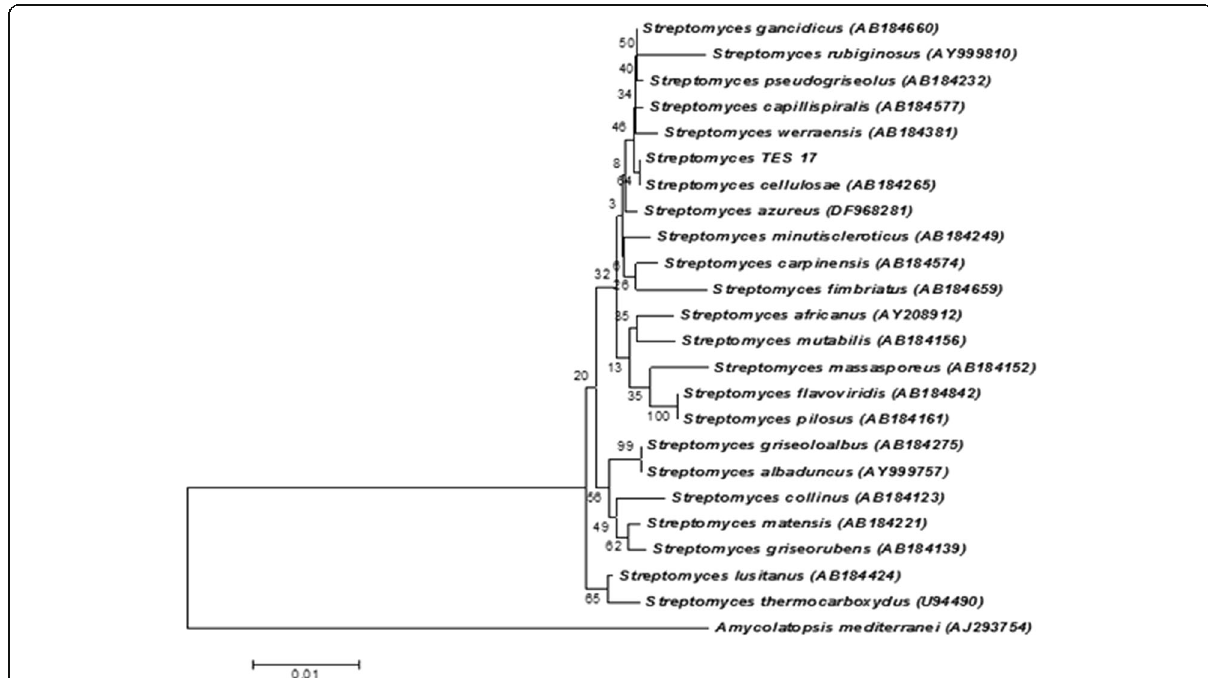
Fig. 2 Neighbor-joining algorithm based on nearly complete 16S rRNA gene sequences showing the position of Streptomyces TES17 amongst its